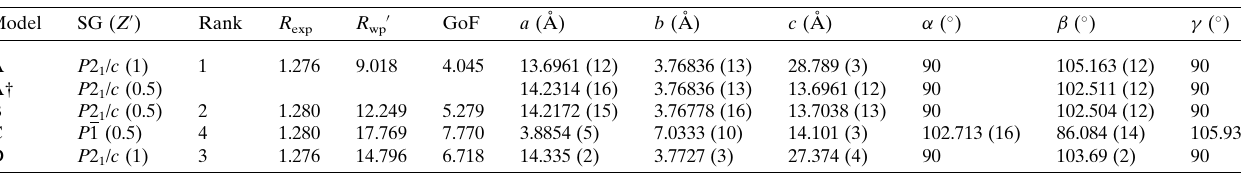
Table 2 Results of the user-controlled Rietveld refinements of models A–D of DFQ. R wp 0 denotes the background-corrected R wp value